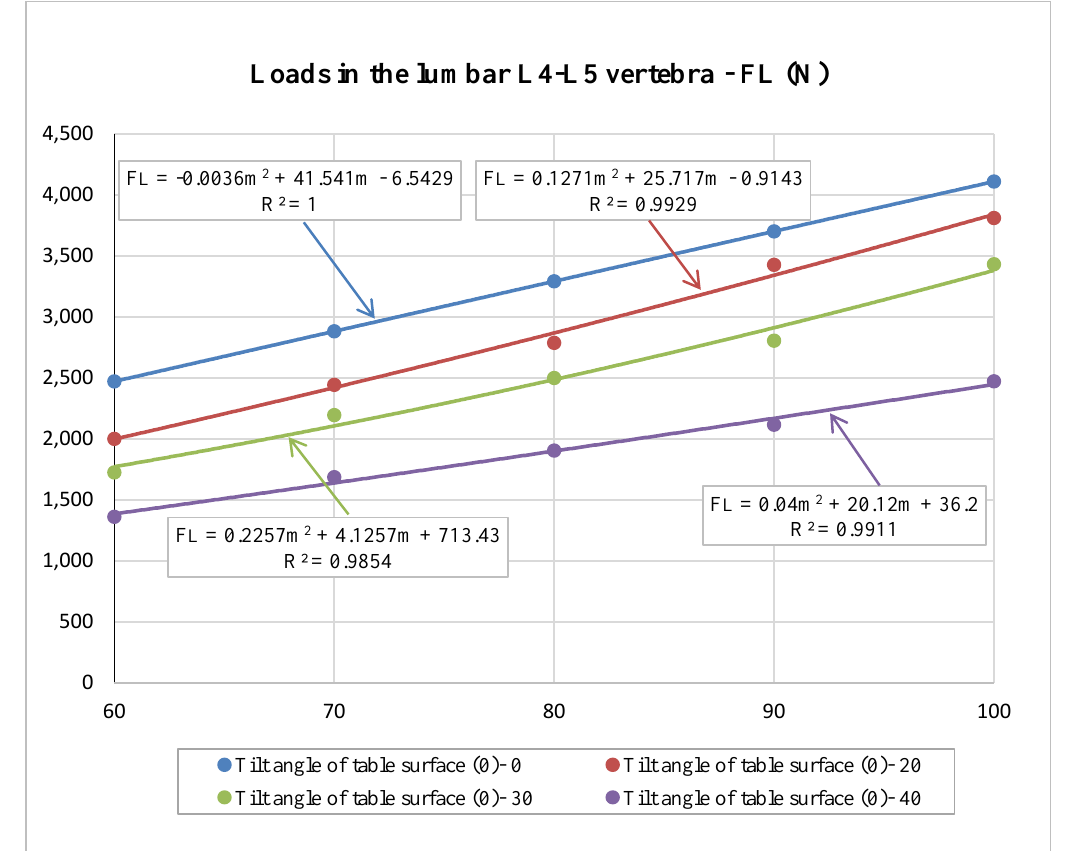
Figure 4. Loads in the lumbar L4-L5 vertebra depending on the mass of the subjects and different angles of inclination of the table